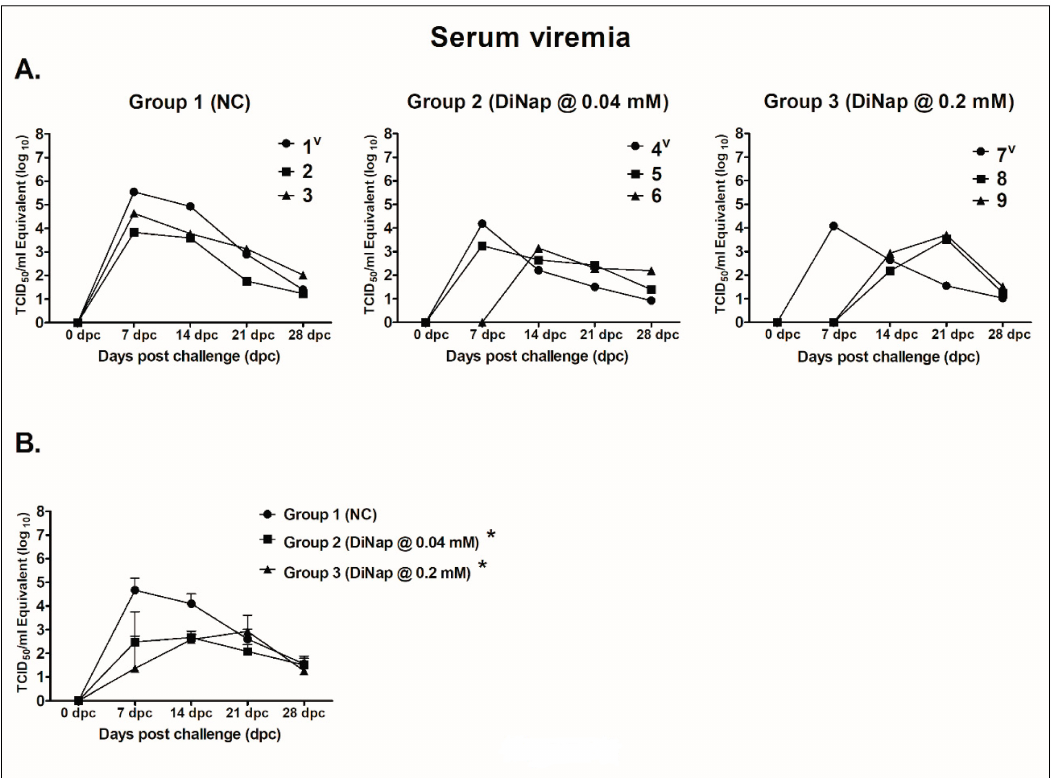
Figure 2. Serum viremia was measured in pig serum from each group at 0 (before challenge), 7, 14, and 28 dpc by real-time reverse transcription-polymerase chain reaction (qRT-PCR) (TaqMan ® ). Viral RNA was extracted from serum samples, and the viral loads were quantified by qRT-PCR. The level of viremia was calculated and expressed as a TCID 50 /mL equivalent based on the standard curve of the cycle threshold (Ct) number plotted against the known virus titer of VR2332. The measured virus titers in the serum samples are presented for individual animals ( A ) and as an average for each group ( B ). Asterisks indicate significant differences (* p < 0.05) in virus titers between groups. Note: v